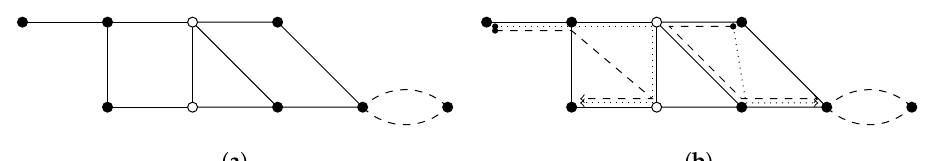
Figure 14. ( a ) Drawing of T i ⊗ T i and left wall vertices of tile T i + 1 . ( b ) Dotted and dashed arrows show two possible combinations for a i , i + 1 ][